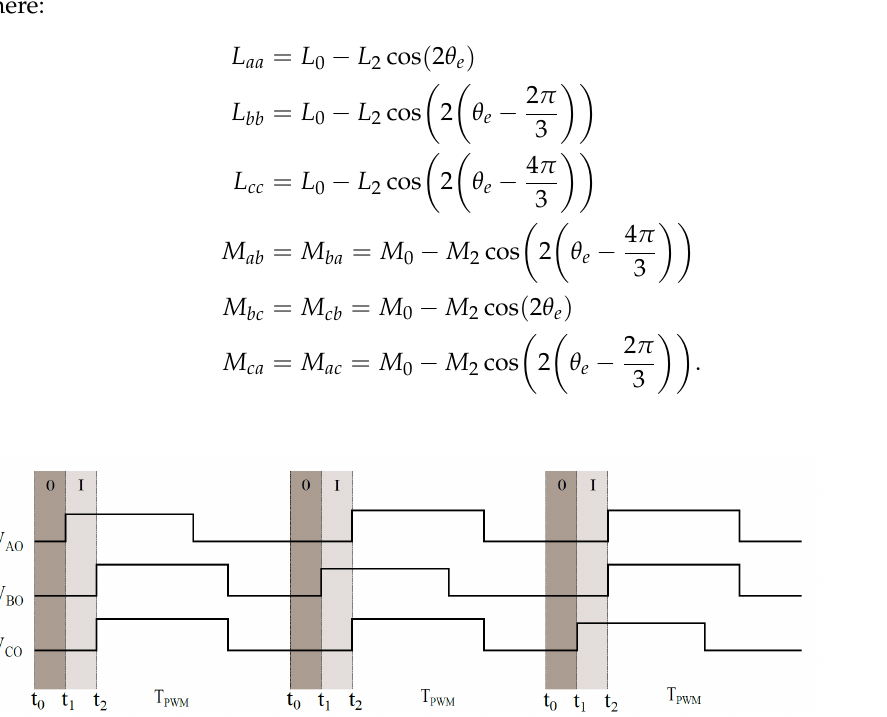
Figure 2. PWM-pattern for the DFC operation. Every phase of the machine is consecutively excited with a modified PWM-pattern. Two star-point voltage measurements are taken at every PWM period, respectively between t 0 and t 1 and t 1 and t 2